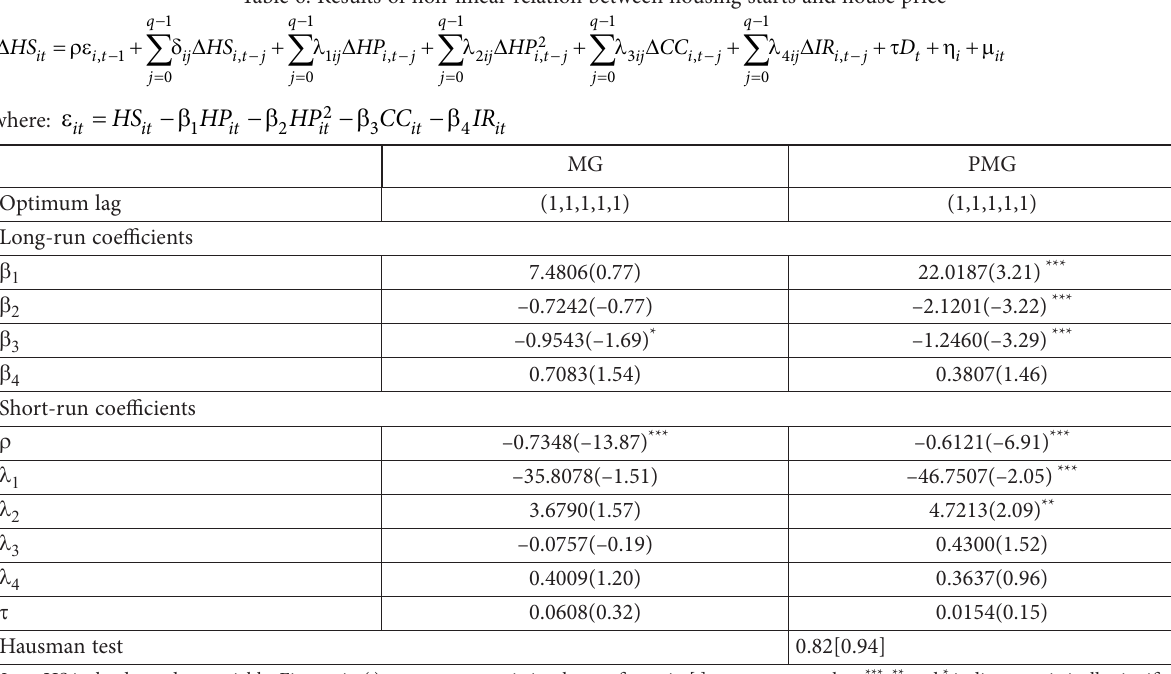
Table 6. Results of non-linear relation between housing starts and house price 1